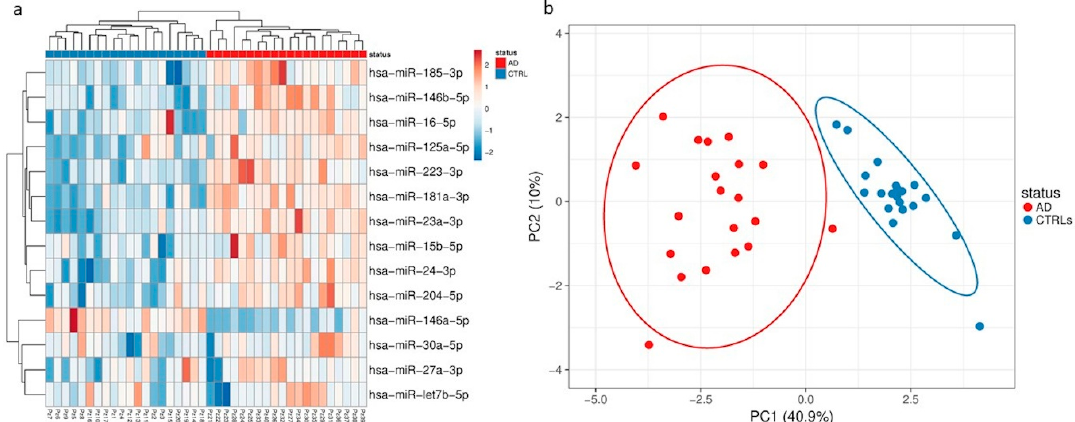
Figure 3. ( a ) Hierarchical clustering of samples based on microRNA (miRNA) profiles observed in total plasma EVs from Alzheimer’s disease (AD) patients and control subjects (CTRLs). The most variant (according to the coefficient of variation) miRNAs were used for clustering analysis (Pearson correlation, average linkage). Rows are centered and unit variance scaling is applied to normalized expression values. Color indicates relative up- (red) or downregulation for each miRNA (row). ( b ) Principle component analysis based on the most variant miRNAs in total plasma EVs.